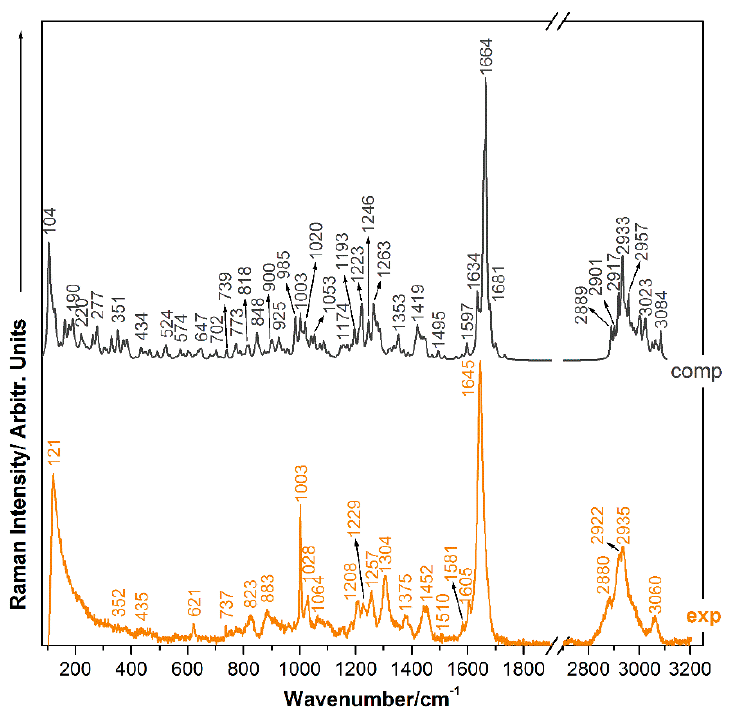
Figure 2. Raman spectrum of NOD (grey) calculated at AFPD/6-311+G(2d,p) level of theory as com- pared to experimental spectrum (orange) registered with 633 nm laser line under ambient condi- tions.